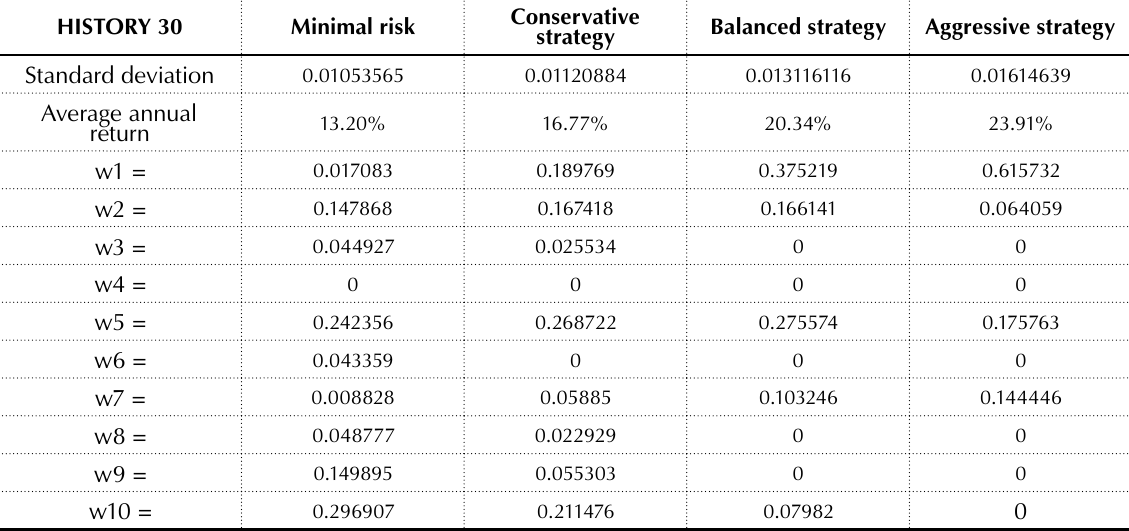
Table 4. Analysis results for the 30-year historical